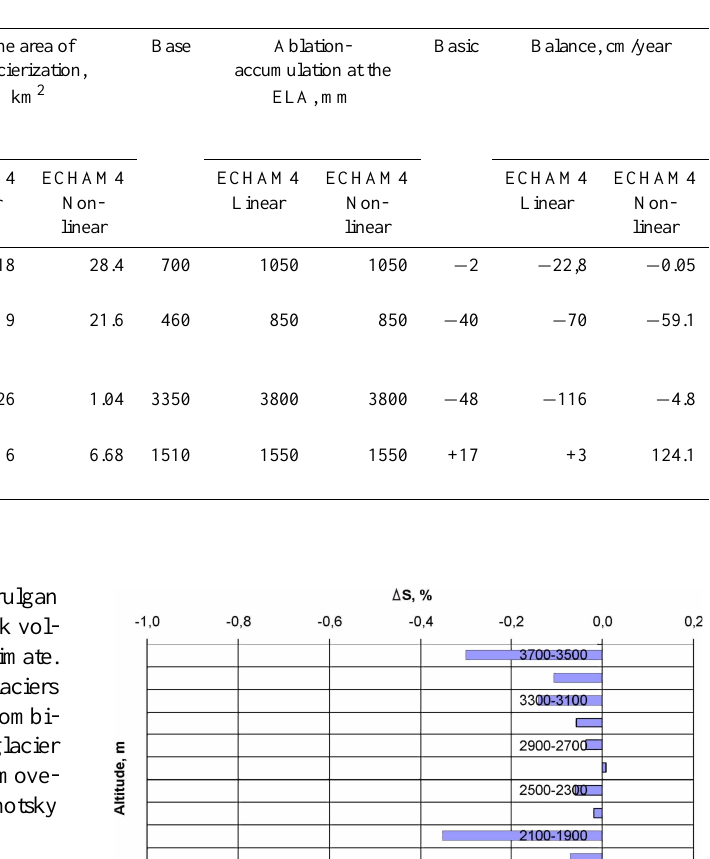
Table 2. Change of the main glacier system characteristics for a “non-linear” distribution of ice versus altitude under climate warming: